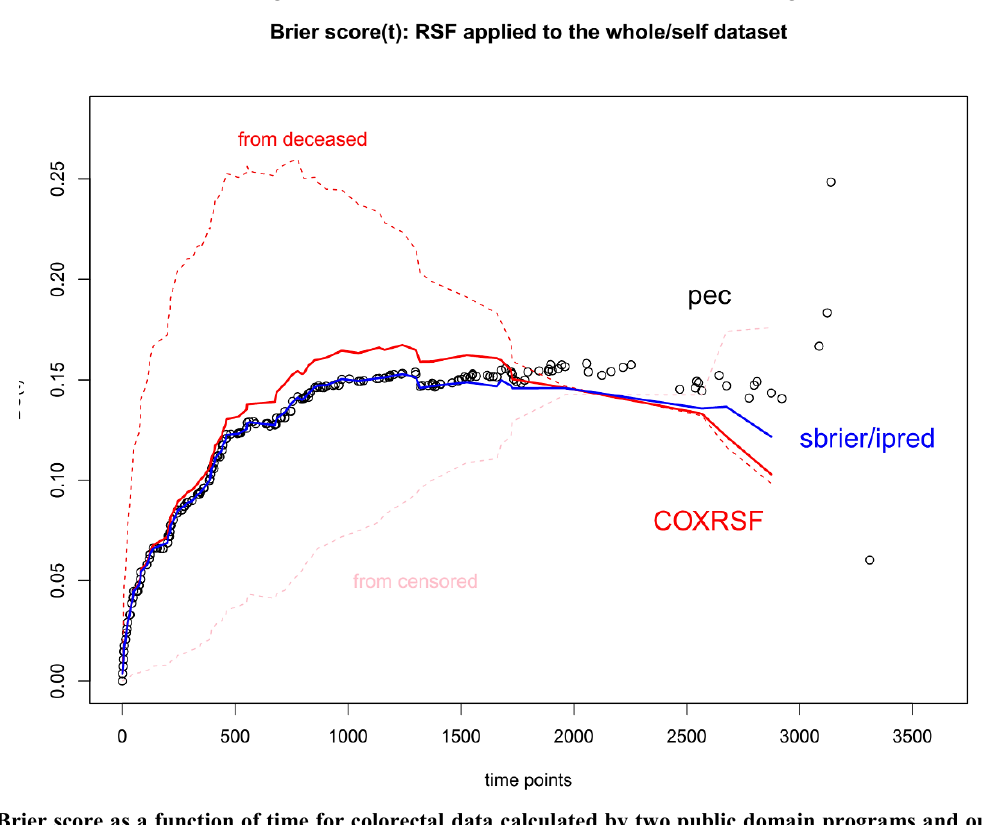
Figure 4. Brier score as a function of time for colorectal data calculated by two public domain programs and our simple R code. This is using the predicted survival function from the trained RSF to the whole dataset (not OOB). (black) from the pec program in the pec R package; (blue) from the sbrier program of the ipred R package; (red solid) from our own simple R codes, where the contribution from the deceased samples (status=1) is in red dashed lines, and contribution from the censored samples (status=0) is in pink dashed